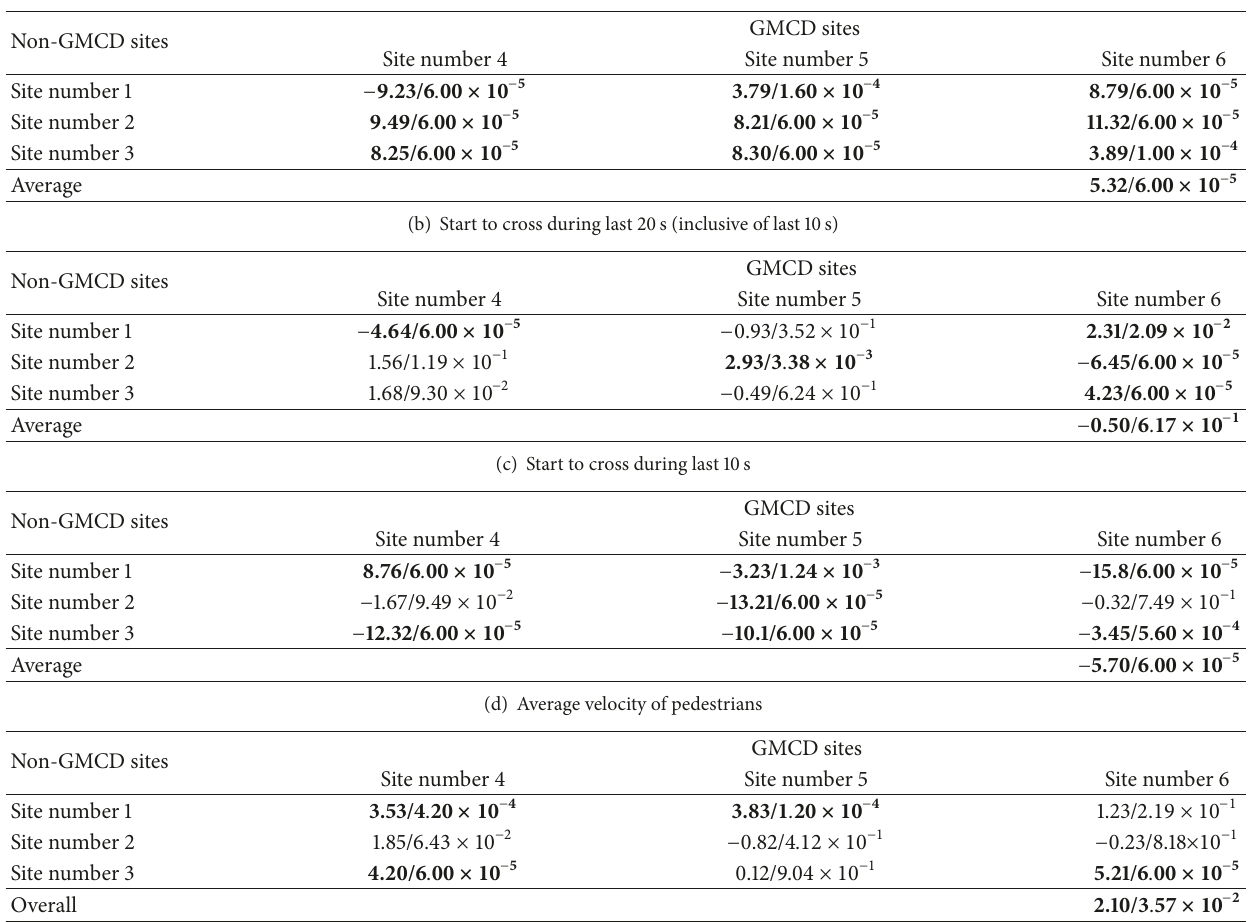
Table 2: Calculated 𝑧 -values/ 𝑝 values of behavior indicators (between non-GMCD and GMCD crosswalks). (a) Start to cross with more than 20s